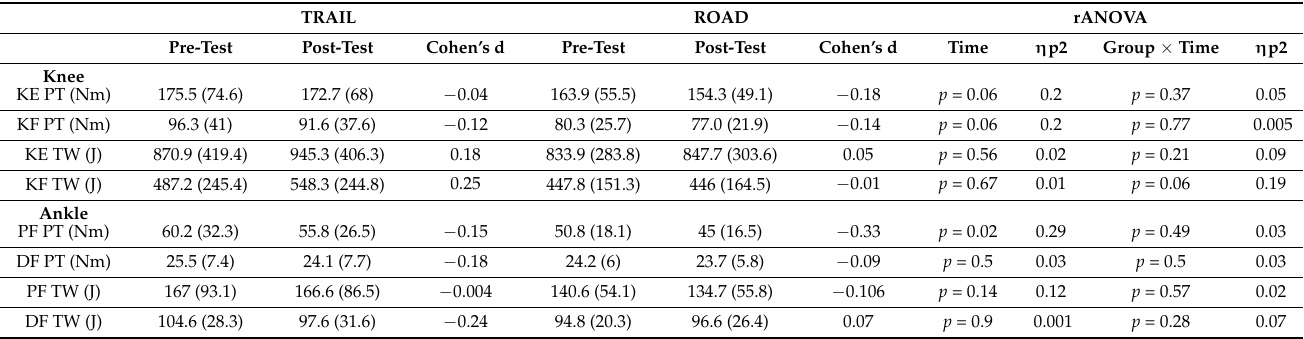
Table 6. Effect on strength.